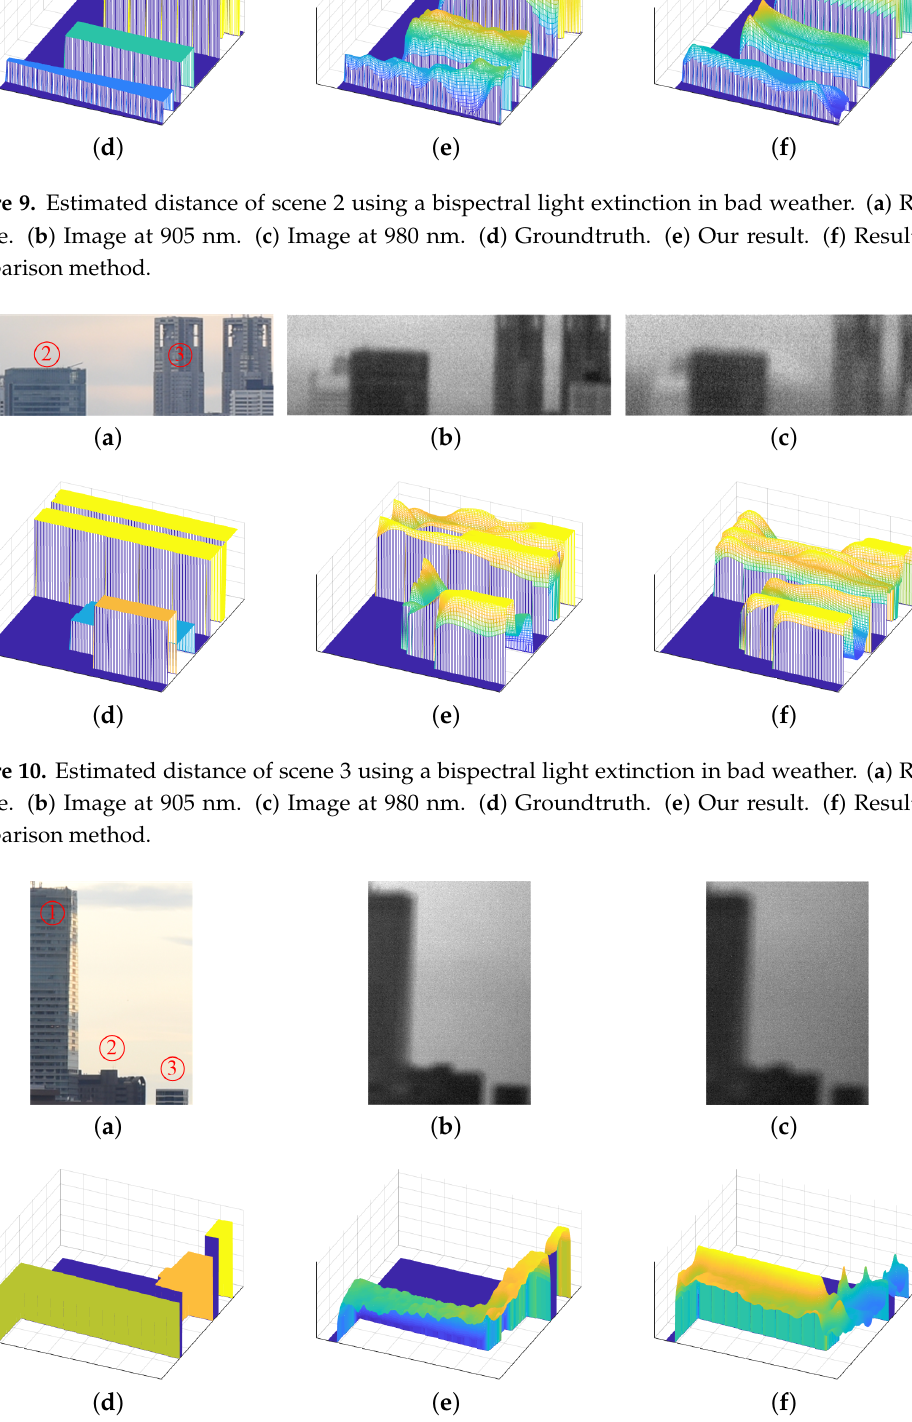
Figure 11. Estimated distance of scene 4 using a bispectral light extinction in bad weather. ( a ) RGB image. ( b ) Image at 905 nm. ( c ) Image at 980 nm. ( d ) Groundtruth. ( e ) Our result. ( f ) Result of comparison